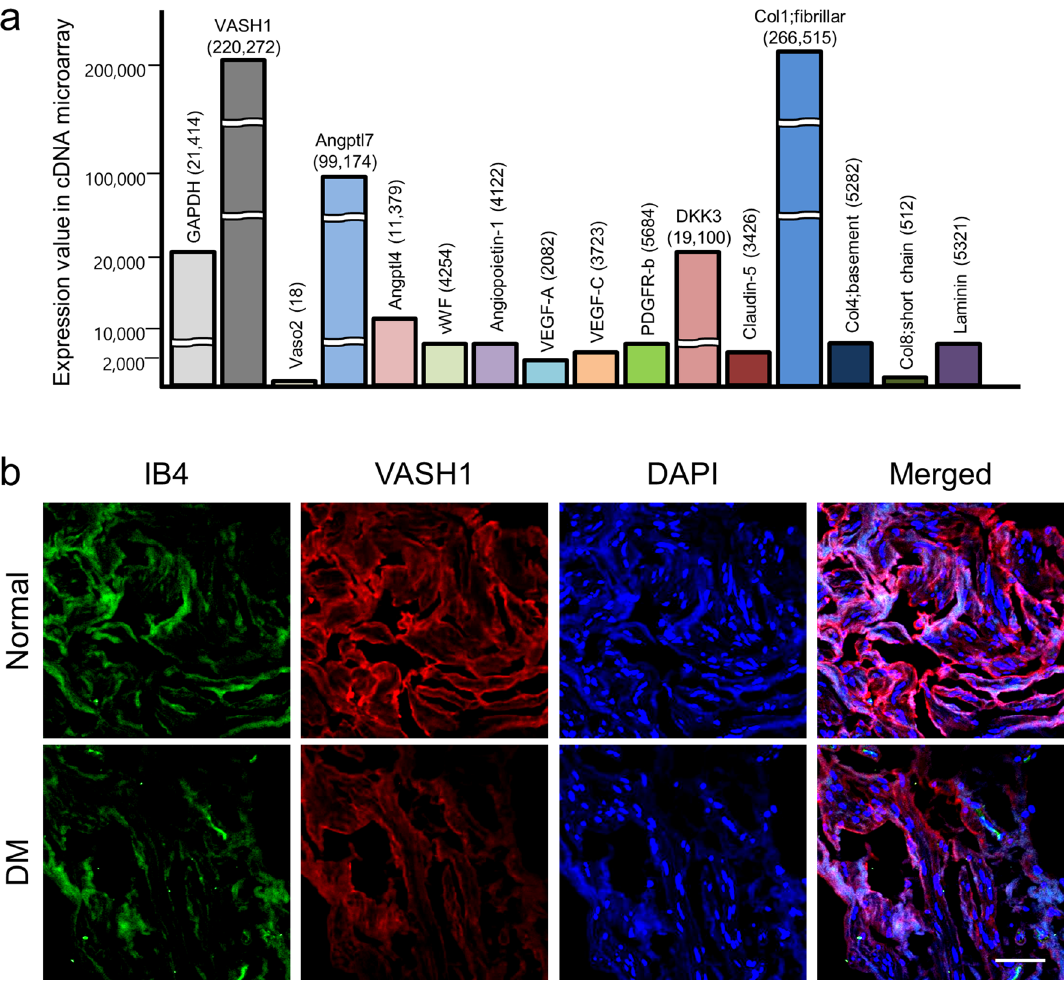
Figure 1. Decreased VASH1 expression under diabetic condition. ( a ) cDNA microarray from mouse corpus cavernosum tissue. The genes that are highly expressed in the erectile tissue has been summarized. ( b ) VASH1 (red) and isolectin IB4 (an endothelial cell marker, green) staining in cavernous tissue from a patient with diabetic erectile dysfunction (IIEF-5 score = 10) or a man with normal potency (IIEF-5 score = 23). Note a significant expression of VASH1 in the endothelial layer. Scale bar = 50 µm. DM diabetes mellitus, IIEF-5 5-item version of the International Index of Erectile